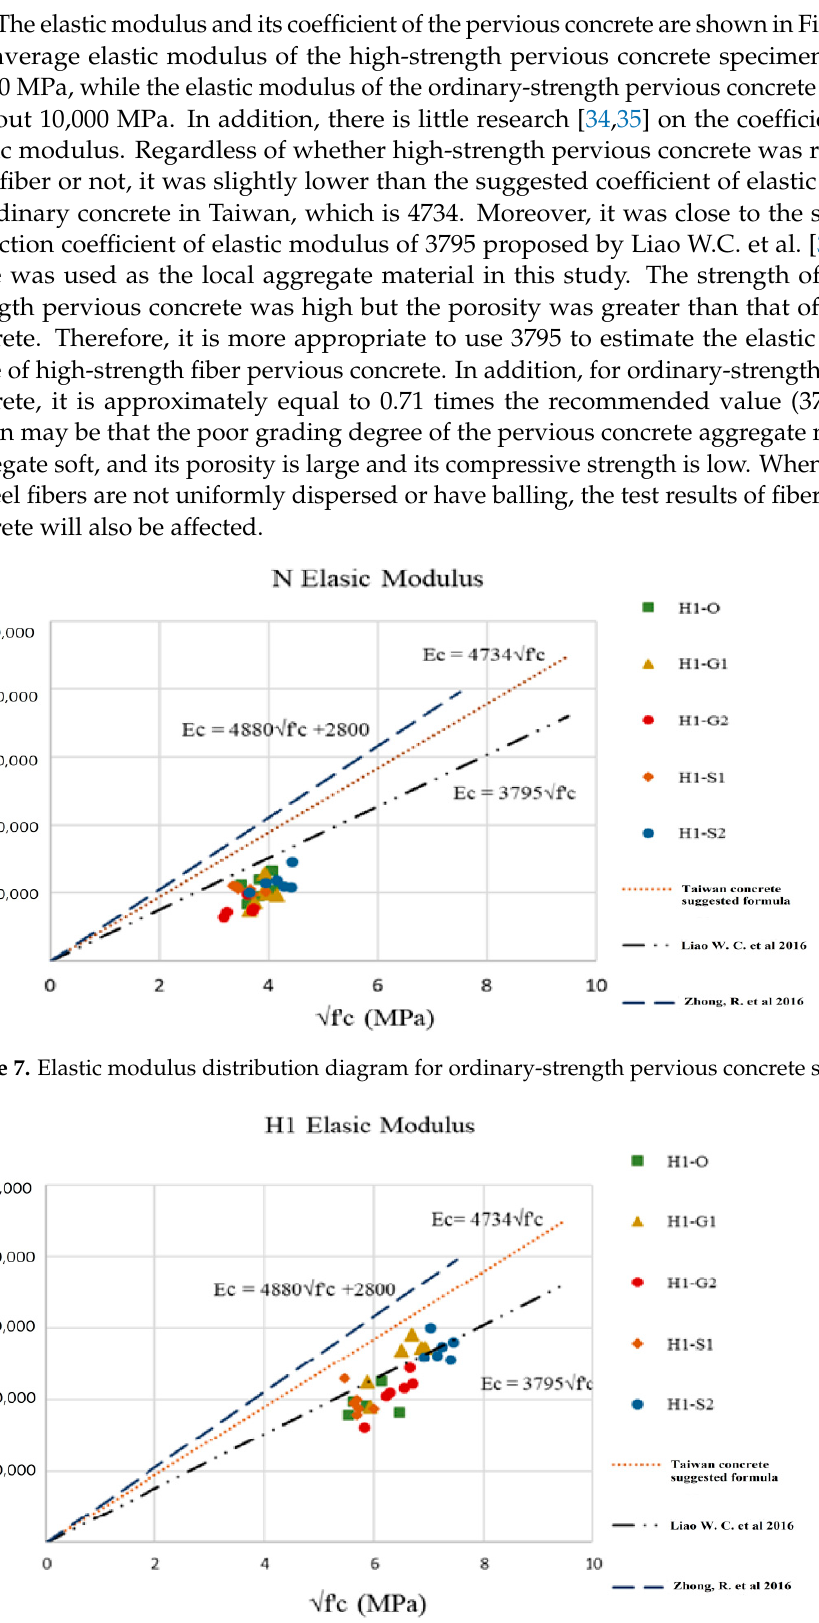
Figure 8. Elastic modulus distribution diagram for H1 high-strength pervious concrete specimens.